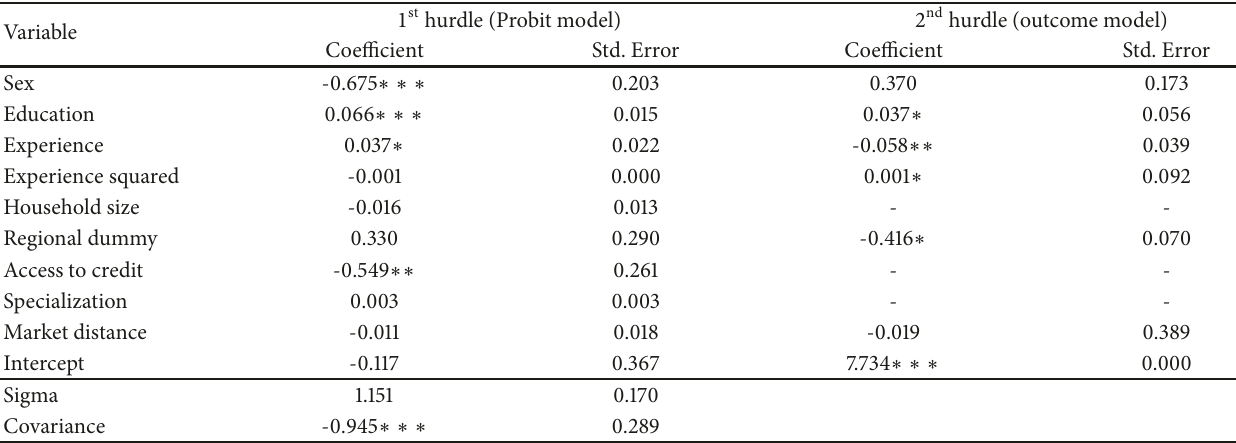
Table 3: Maximum likelihood estimates of double-hurdle model for participation in off-farm work and amount of off-farm income.